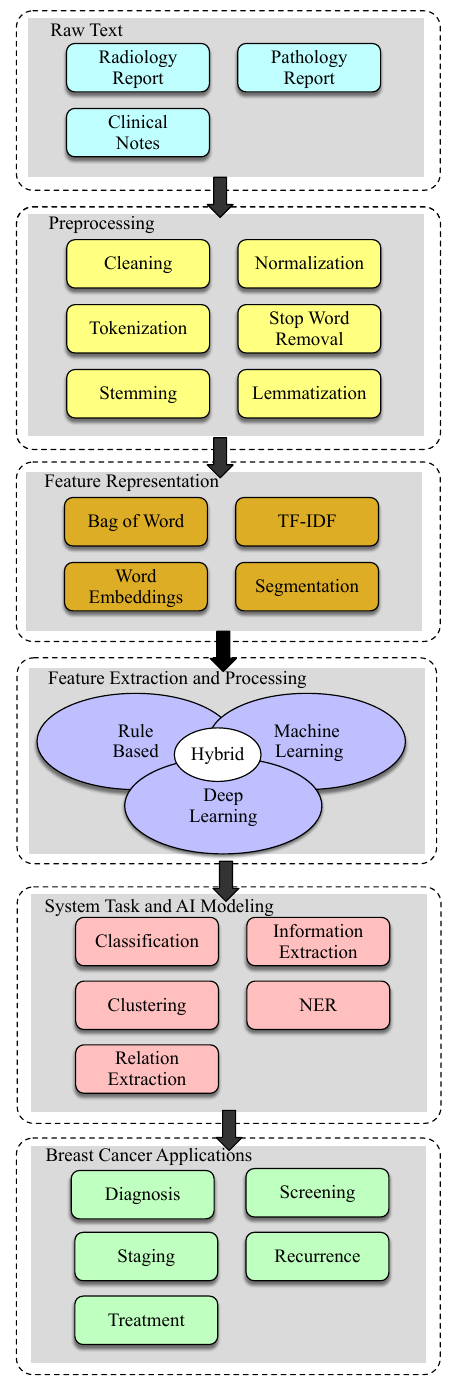
Figure 2. The typical NLP pipeline involves four main steps: text preprocessing, feature represen- tation, feature extraction and processing, and system tasks. Raw text is the input layer and breast cancer applications are the last layer. We discuss the detailed applications in Section